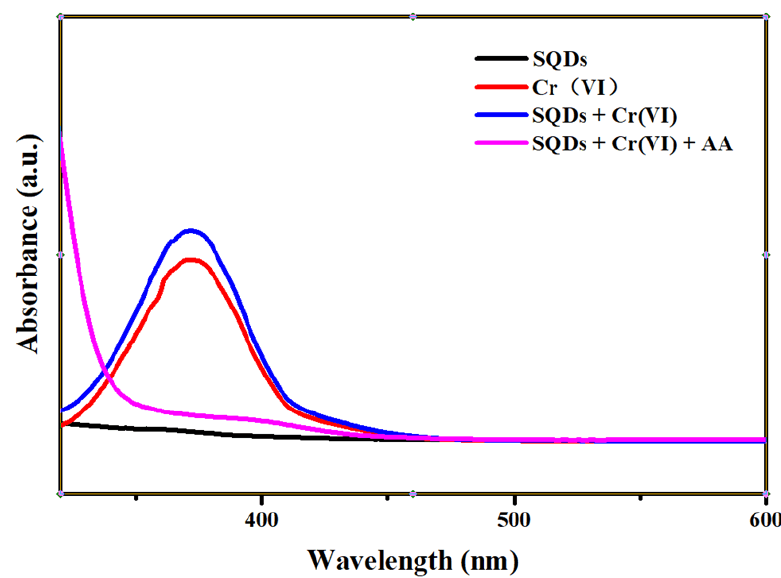
Figure 3. UV-vis absorption spectra of different solutions.